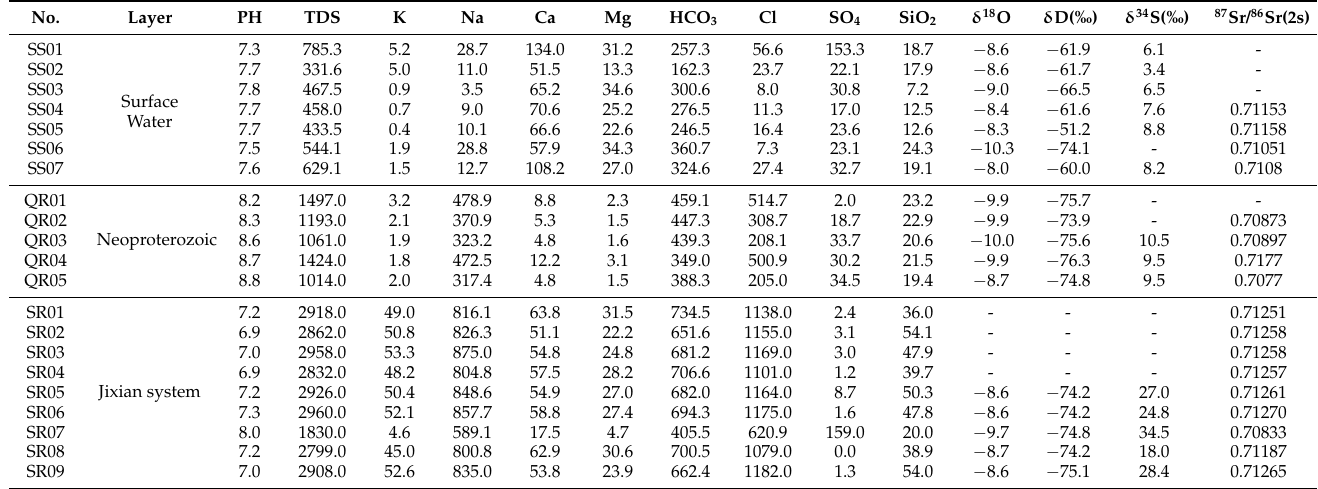
Table 1. Hydrogeochemical data